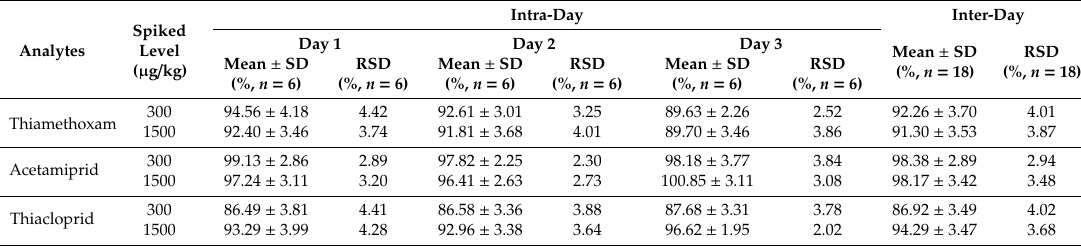
Table 1. Accuracy and precision of the proposed method at two spiked